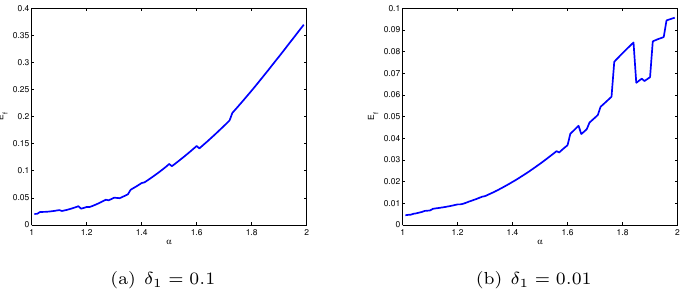
Figure 5. The variation of E f with α (Example 2).